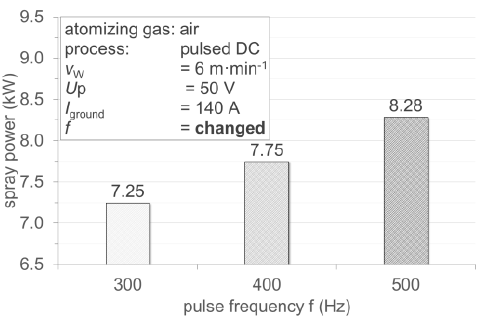
Figure 12. Comparison of the spray power as a function of the pulse frequency with pulsed direct current.